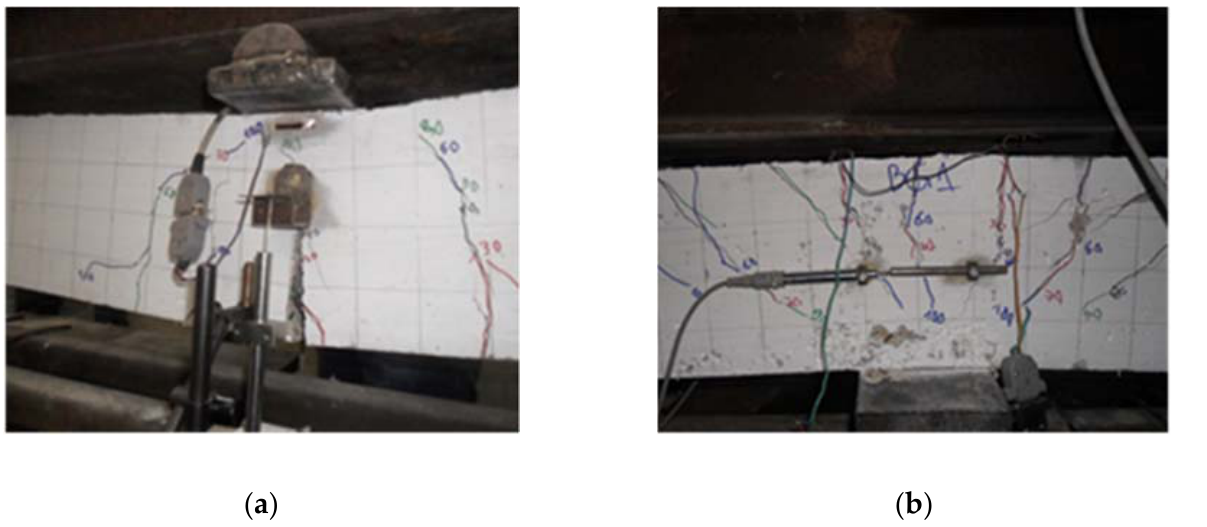
Figure 17. Beam B-G1: ( a ) Disposition of cracks and failure of the cross-section at mid-span; ( b ) Disposition of cracks and